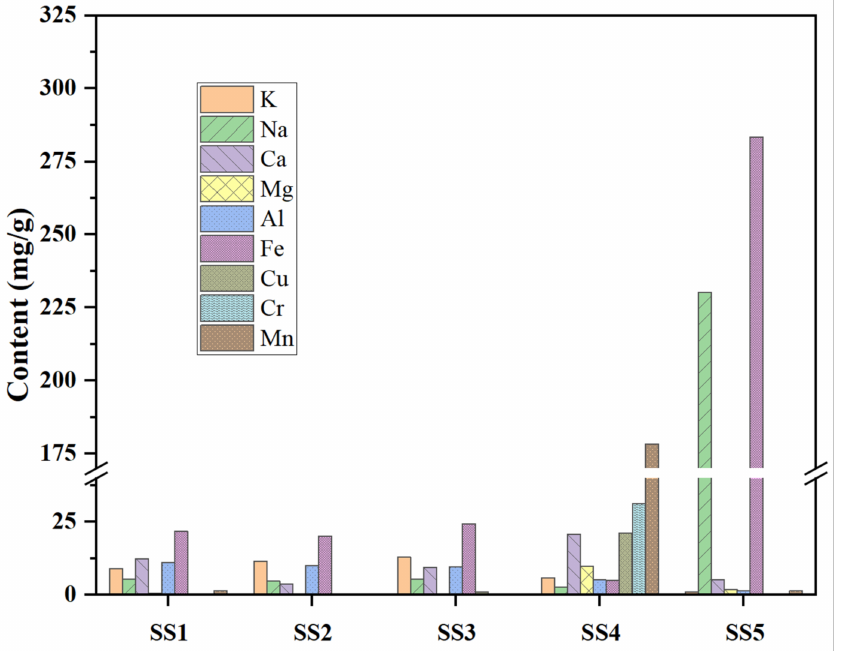
Figure 1. Elemental characteristics of